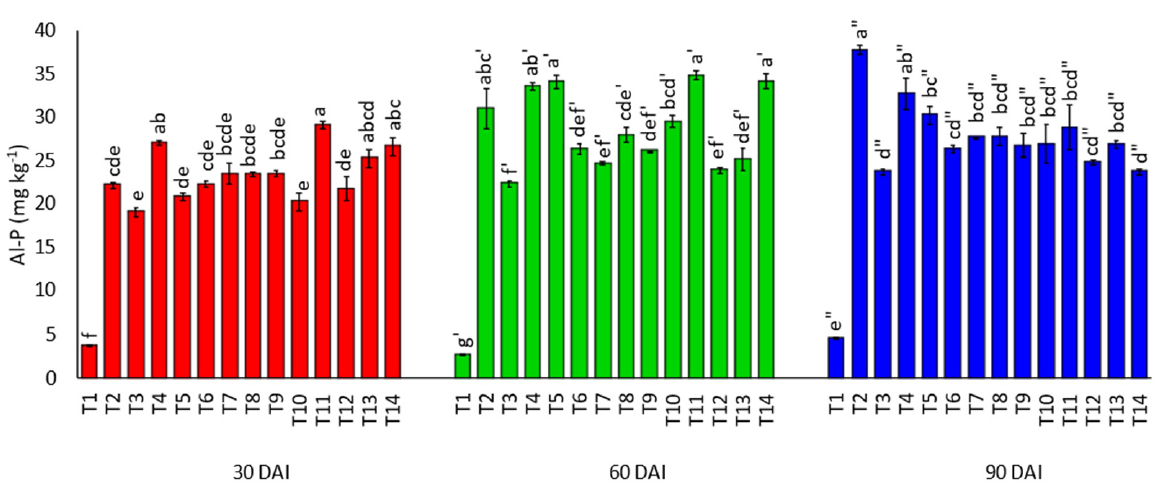
Figure 17. Effects of treatments on aluminium-bound phosphorus after thirty, sixty, and ninety days of incubation, where T1: soil alone, T2: Egypt rock phosphate alone, T3: Egypt rock phosphate + 100% charcoal, T4: Egypt rock phosphate + 100% sago bark ash, and T5: Egypt rock phosphate + 100% charcoal + 100% sago bark ash, T6: Egypt rock phosphate + 75% charcoal + 75% sago bark ash, T7: Egypt rock phosphate + 50% charcoal + 75% sago bark ash, T8: Egypt rock phosphate + 25% charcoal + 75% sago bark ash, T9: Egypt rock phosphate + 75% charcoal + 50% sago bark ash, T10: Egypt rock phosphate + 50% charcoal + 50% sago bark ash, T11: Egypt rock phosphate + 25% charcoal + 50% sago bark ash, T12: Egypt rock phosphate + 75% charcoal + 25% sago bark ash, T13: Egypt rock phosphate + 50% charcoal + 25% sago bark ash, and T14: Egypt rock phosphate + 25% charcoal + 25% sago bark ash. Means with different letter(s) within the same incubation period indicate significant differences between treatments according to Tukey’s HSD test at p ≤ 0.05, i.e., a > b > c. Bars represent the mean values ± SE.